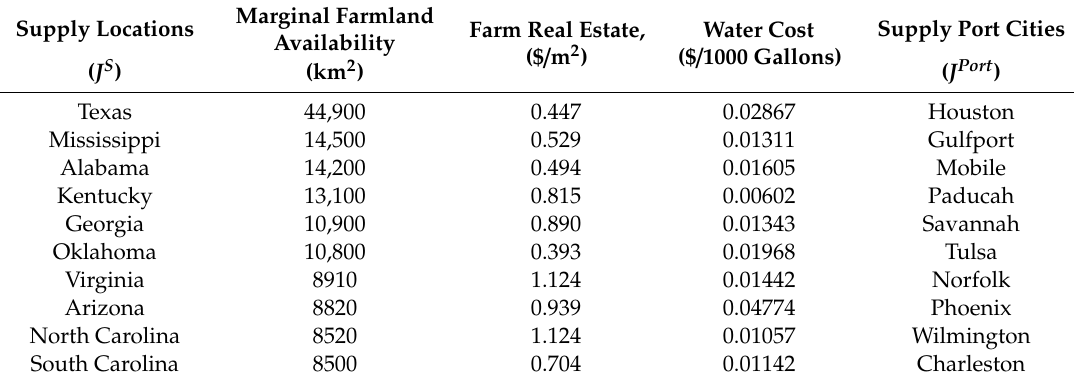
Table 3. Supply locations for the United States case of the algal biomass to biodiesel problem. Marginal Farmland Supply Locations Farm Real Availability